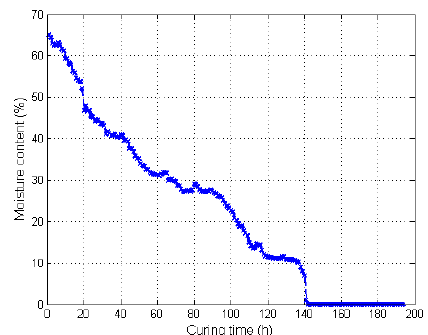
Figure 14. The moisture content of tobacco during curing.